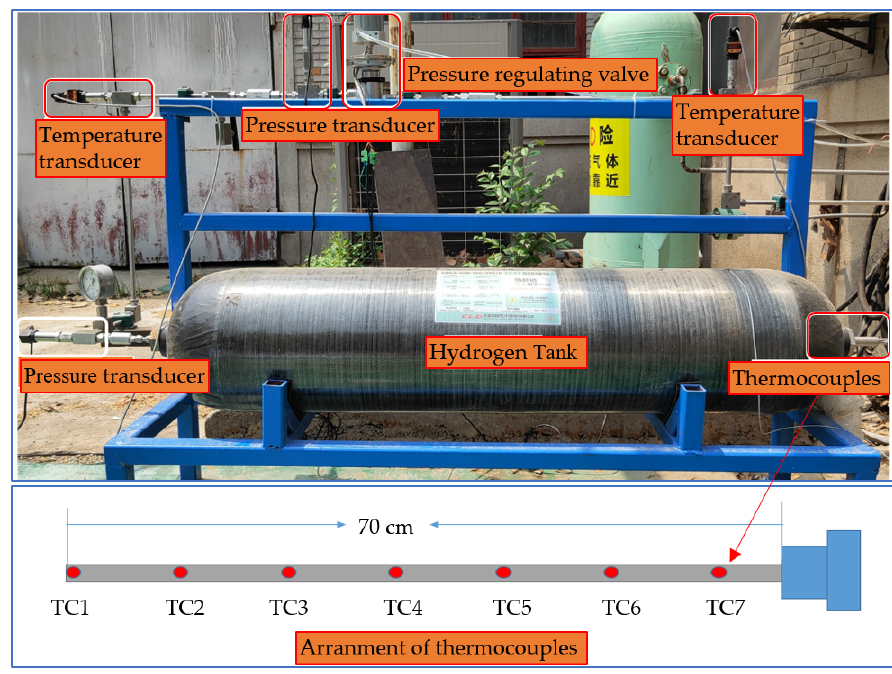
Figure 2. Test rig for the fast-filling